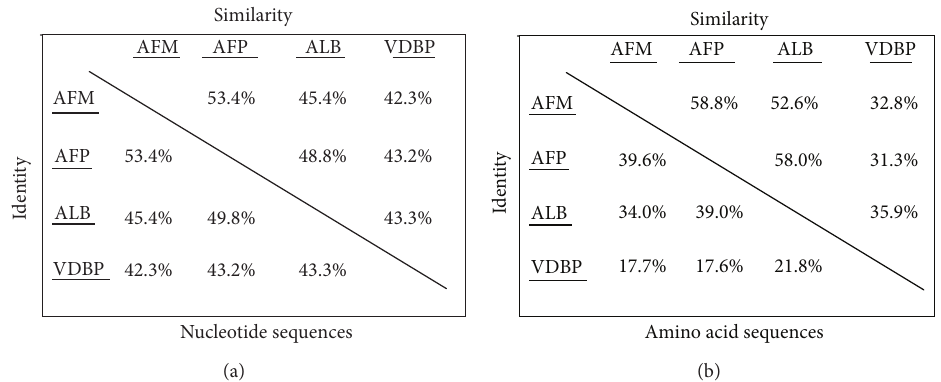
Figure 1: Comparison of percent similarity and identity of nucleotide sequences and amino acid sequences of human albumin superfamily members.